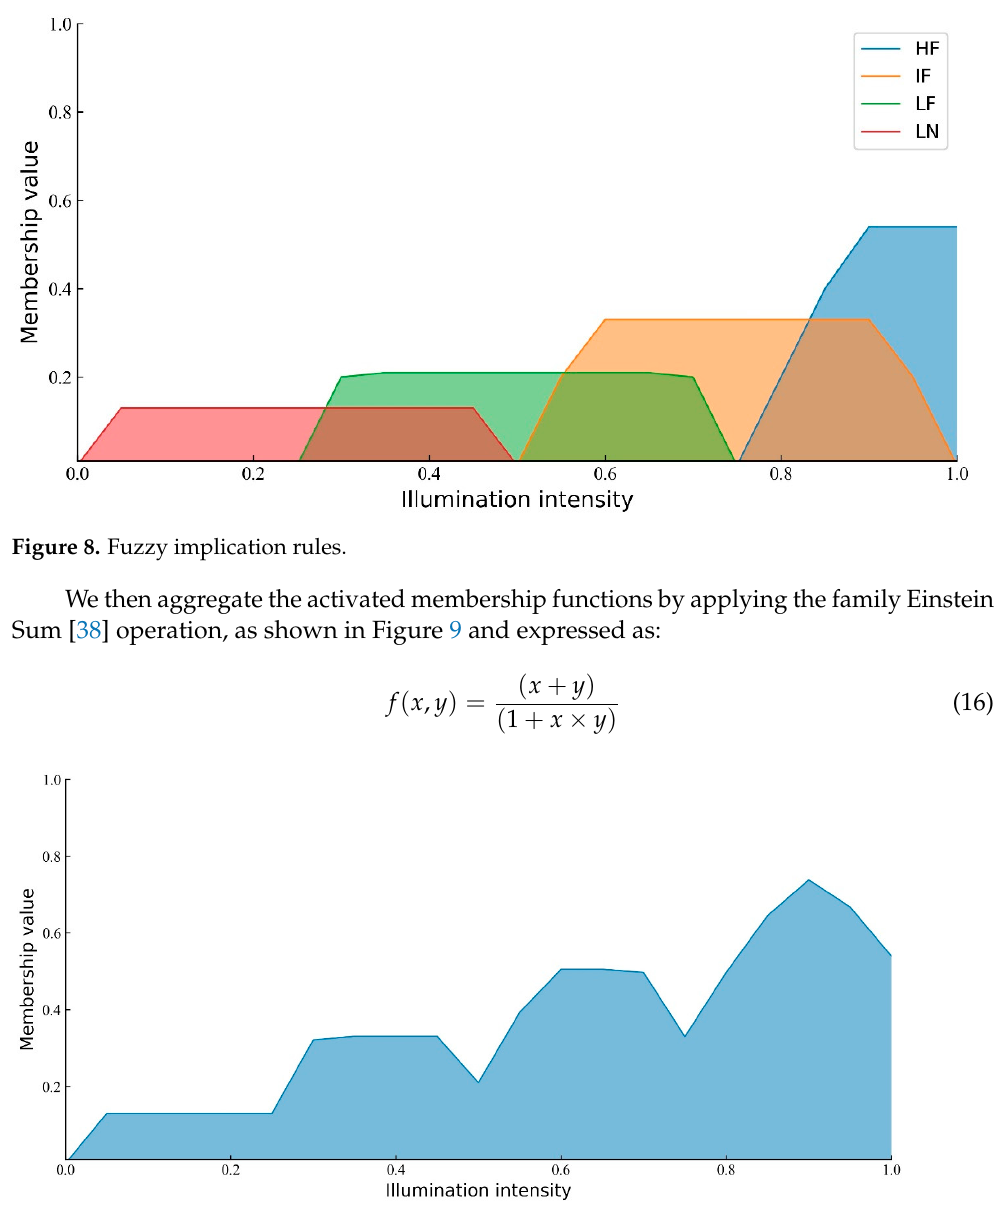
Figure 9. The aggregation rules.